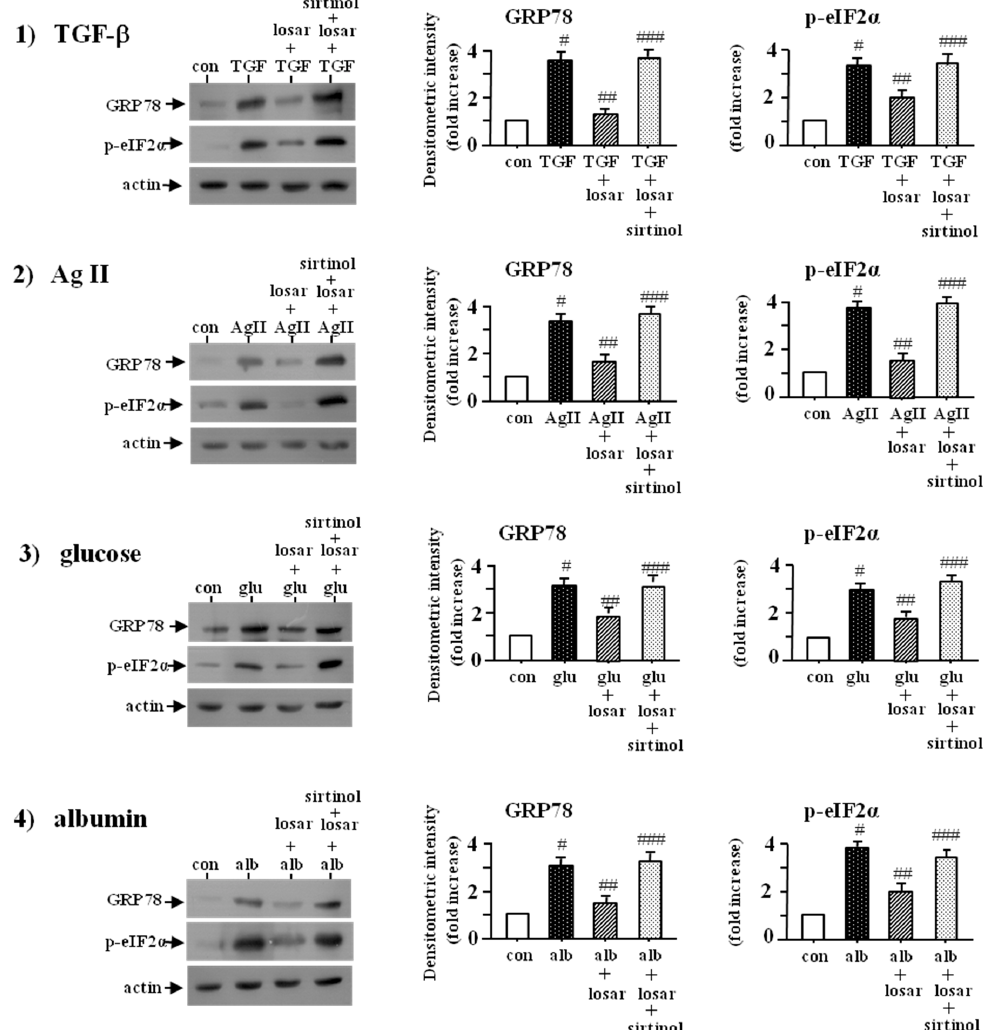
Figure 7. Inhibition of TGF- β -, angiotensin II-, high glucose-, and albumin-induced ER stress by losartan, which were blocked by sirtinol. Proximal tubular cells were incubated with (tumor growth factor- β ) TGF- β (10 ng/mL), angiotensin II (AgII, 1 µM), high glucose (glu, 30 mM), and albumin (alb, 5 mg/mL) for three days and then treated with or without losartan (losar, 10 µM) and sirtinol (SIRT1 inhibitor, 10 µM) for two days. Expression of GRP78 and p-eIF2 α was examined by Western blot analysis. The relative densities of the bands for GRP78 and p-eIF2 α were normalized to those for actin for standardization. Representative blots and quantitative analysis from three independent experiments were shown. Results were expressed as n -fold increase over control as mean ± S.E. #: p < 0.05 vs. con (control); ##: p < 0.05 vs. TGF- β ; AgII, glu or alb; ###: p < 0.05 vs. TGF- β + losar, AgII + losar, glu + losar, or alb +